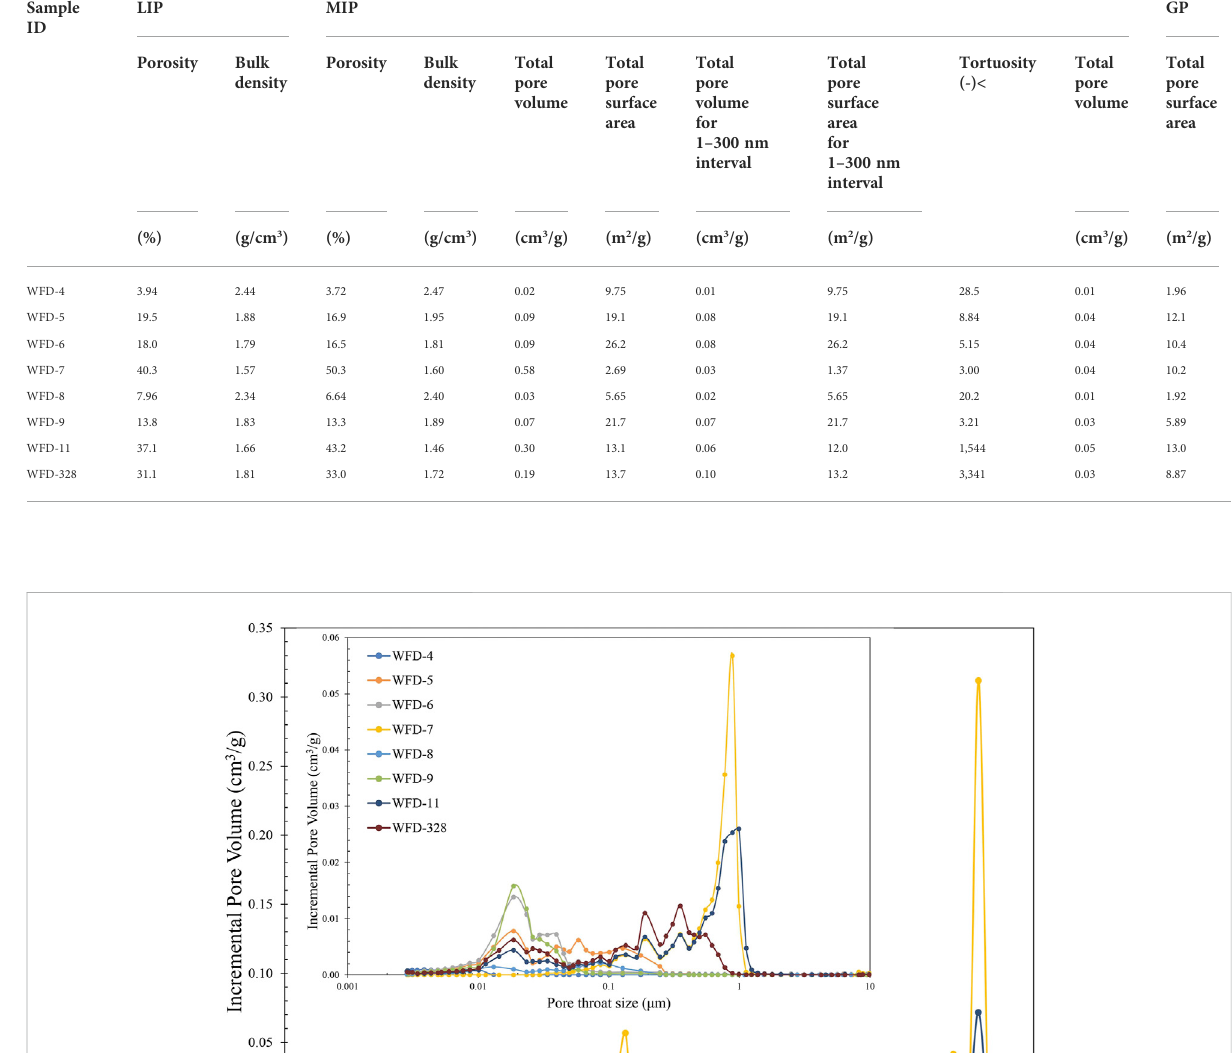
TABLE 2 Porosity, pore volume, surface area, and tortuosity obtained from three methods, (-) means dimensionless.